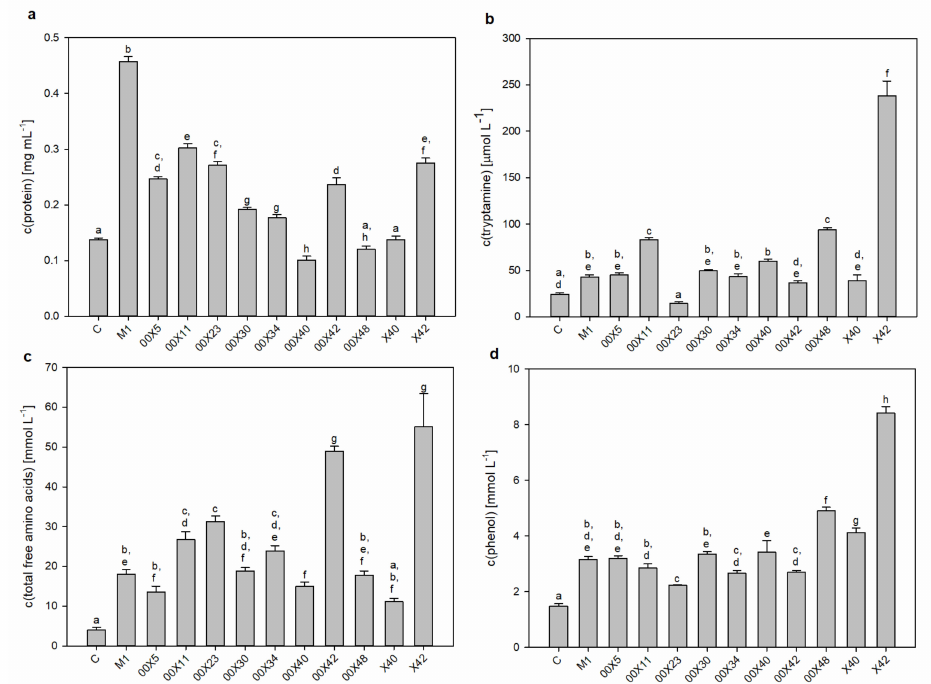
Figure 2. Characterization of compounds secreted into the medium by Pythium strains: protein content ( a ), tryptamine content ( b ), total free amino acids ( c ), total phenolics ( d ). Each code (00X5, 00X11,